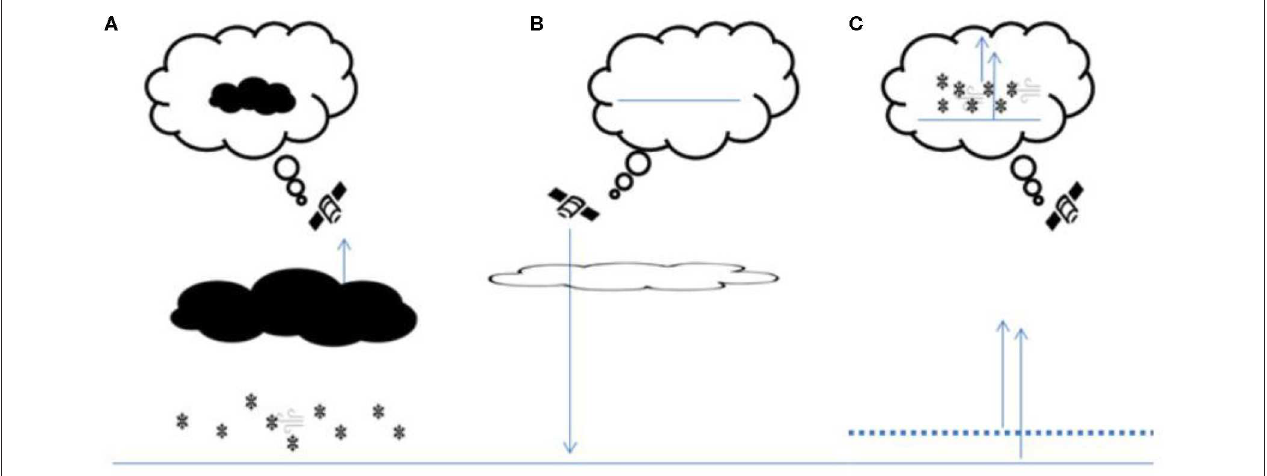
FIGURE 5 | Possible type of blowing snow commission/omission and cloud/clear sky mis-classification. (A) The ceilometer-based BSD detects a blowing snow layer overlaid by clouds, while the satellite detects clear sky and effectively misses the blowing snow. (B) The ceilometer detects a cloud, which is transmissive and seen through by the satellite. (C) The satellite algorithm detects a blowing snow layer unseen by the ceilometer (possibly due to the pollution of the first bin above ground, misinterpretation of the ground return or of a low cloud or fog as blowing snow).